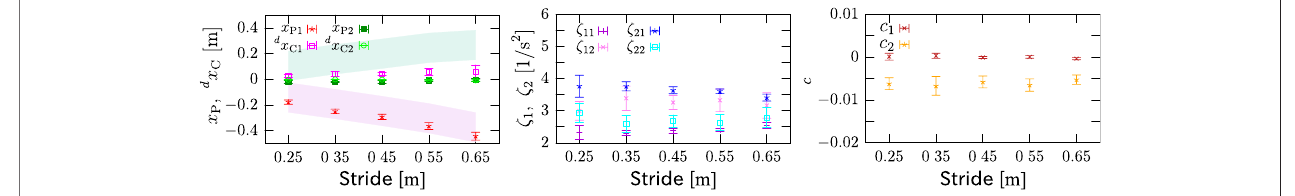
FIGURE 15 | Identi fi ed parameters. Left: positions of pivot point and landing destination. Final position ofCOM is reset to be the original point. Magenta and green areasrepresentsolesofpivotandlandingfeet,respectively.